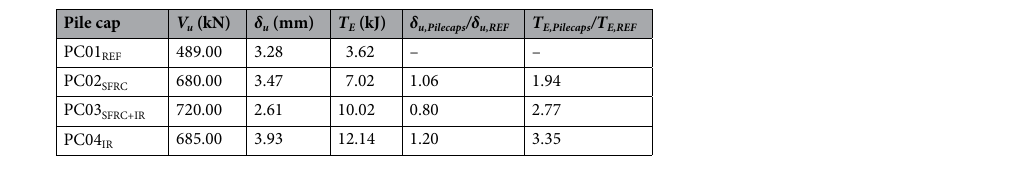
Table 7. Parameters defining the V − δ ratio.